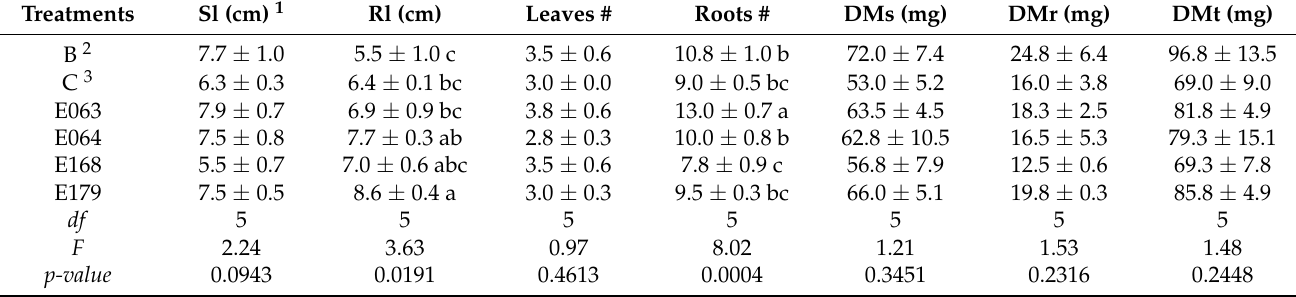
Table 2. Effect of the pre-emergence application of endophytic extracts on different growth traits (Sl: shoot length; Rl: root length; number of leaves and roots; DMs: shoot dry matter weight; DMr: